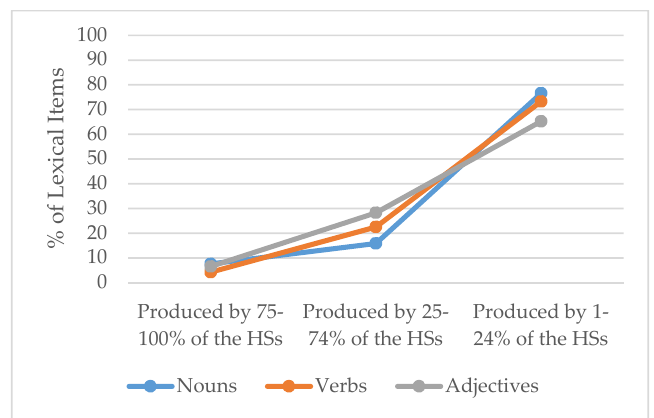
Figure 4. Distribution of word frequency per grammatical category in the heritage speakers (HS) group.